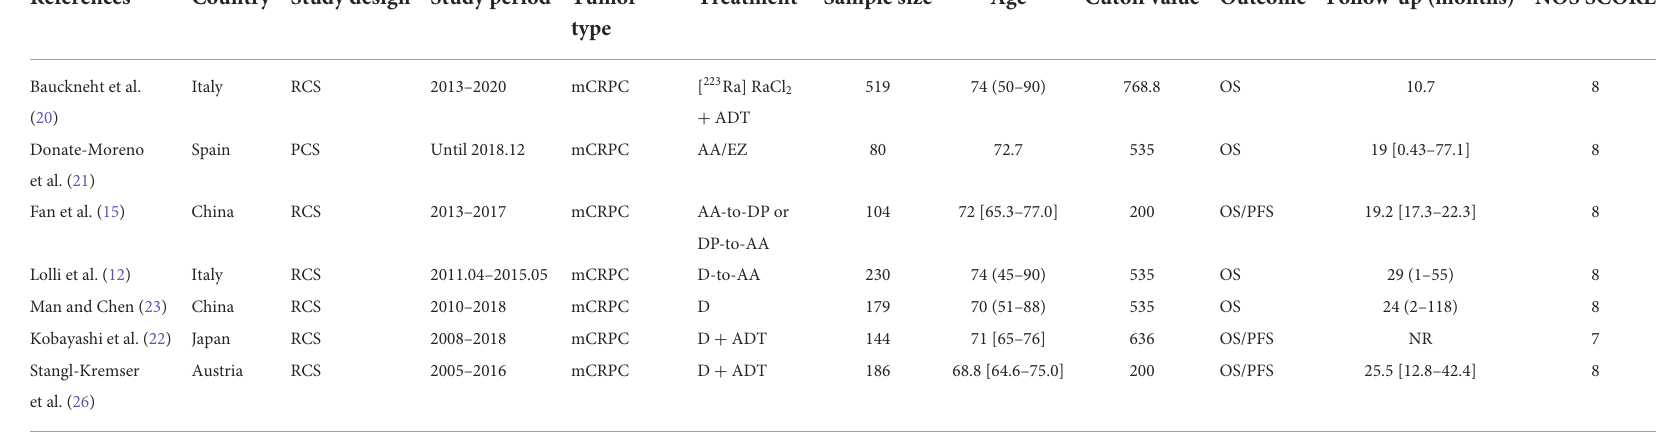
TABLE 1 Baseline characteristics of included mCRPC patients.